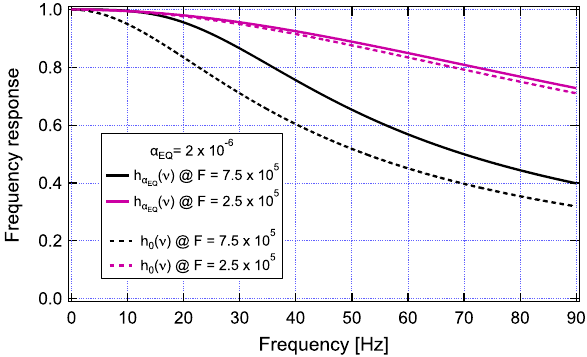
(ν) (solid lines) with h (ν) (dashed lines) Fig. 4 Comparison of h α 0 EQ for two finesse values and for α EQ = 2 × 10 − 6 rad. As can be seen the two functions differ significantly especially at the higher finesse value where N α EQ / 2 approaches